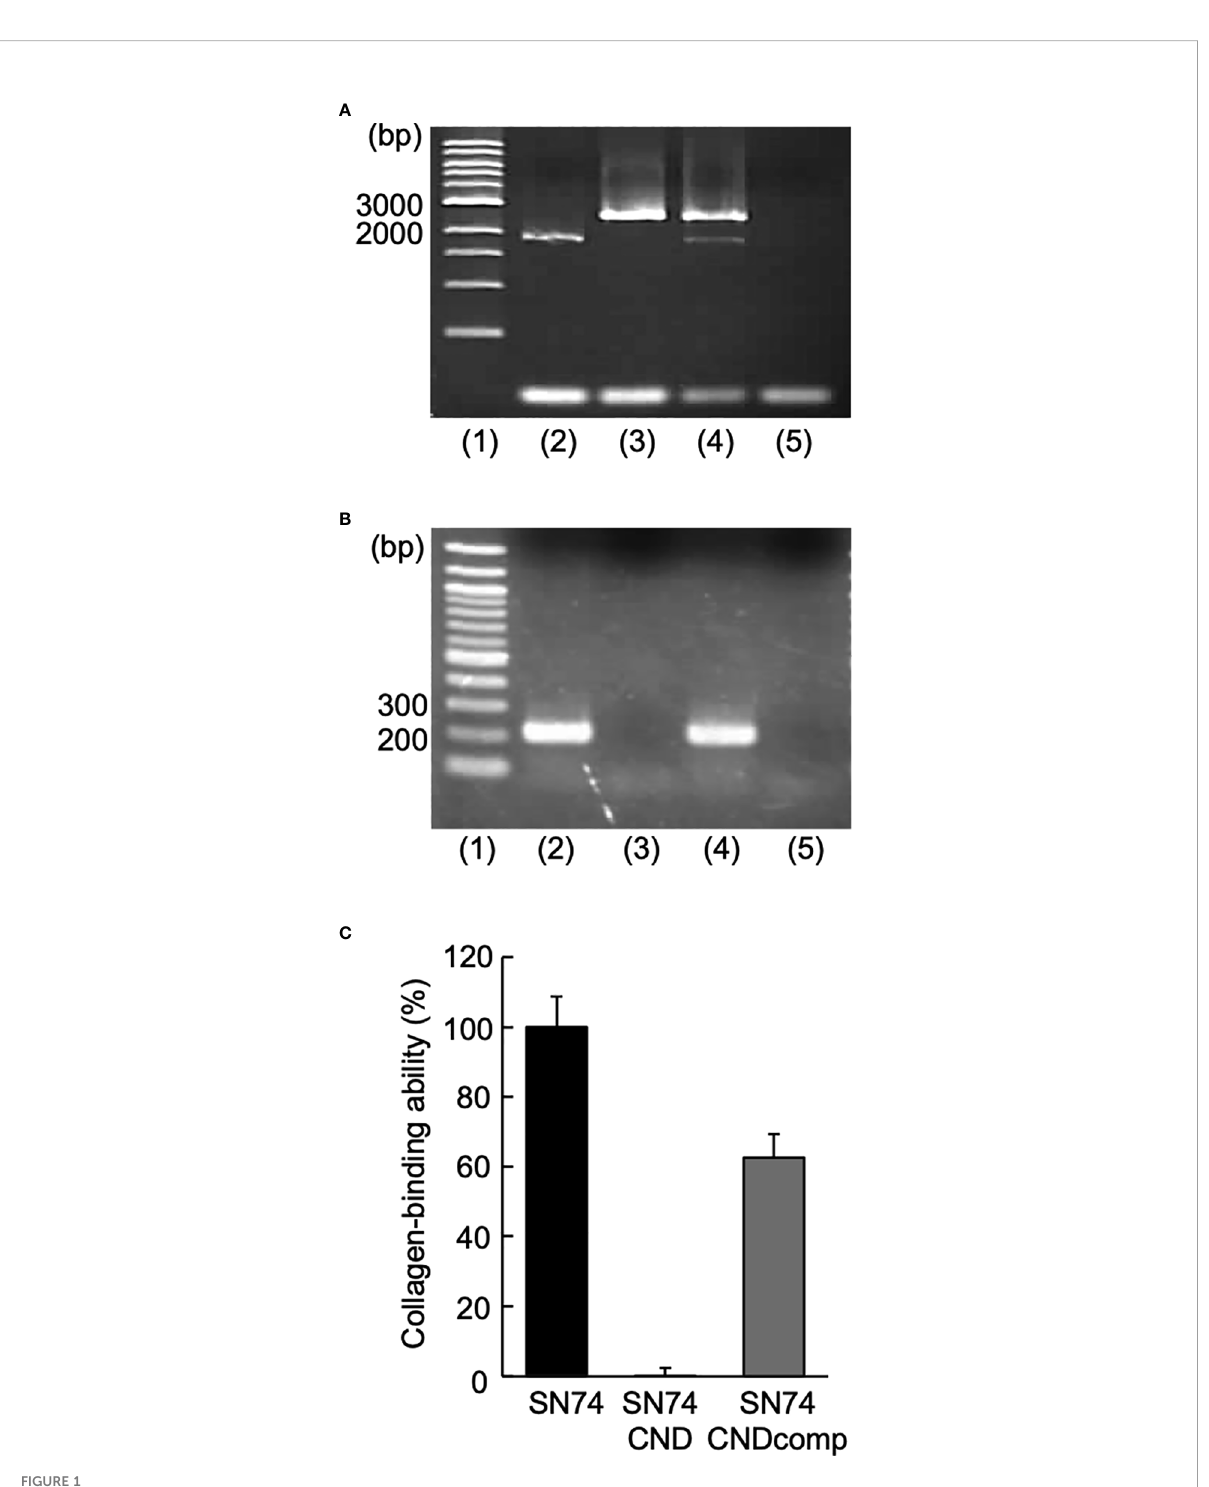
FIGURE 1 Construction of Streptococcus mutans strains SN74CND and SN74CNDcomp. (A) Con fi rmation of chromosomal DNA [lane 1: 1-kbp DNA ladder, 2: strain SN74 (the parental strain), 3: strain SN74CND (the cnm deletion strain), 4: strain SN74CNDcomp (complementation of the cnm deletion strain), and 5: MilliQ water as a negative control). (B) Con fi rmation of cDNA using reverse transcription-PCR (lane 1: 100-bp DNA ladder; 2: strain SN74; 3: strain SN74CND; 4: strain SN74CNDcomp; 5: ultrapure water as a negative control). (C) Collagen binding ability. The results for each strain are expressed as a percentage relative to the binding ability of parental strain SN74, which was de fi ned as 100%. Data are presented as the mean ± SD from fi ve independent